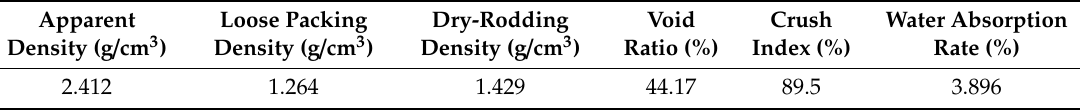
Table 2. Physical performance of recycled coarse aggregate.